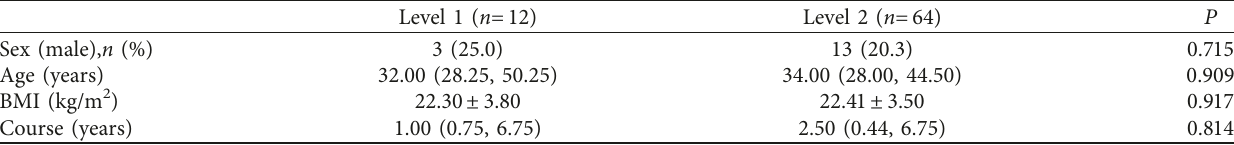
Table 1: Baseline clinical characteristics of the 76 subjects according to color Doppler ultrasound grading.